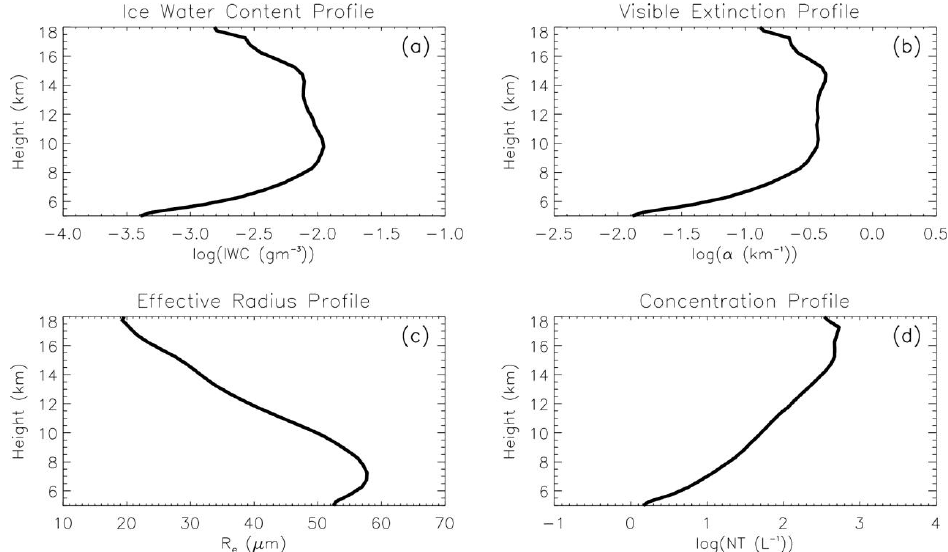
Figure 6: Mean vertical profiles of the microphysical and radiative properties of ice clouds: (a) ice water content (in gm − 3 ) , (b) visible extinction (in km − 1 ) , (c) effective radius (in µm) and (d) total concentration (in l − 1 ) over Darwin.